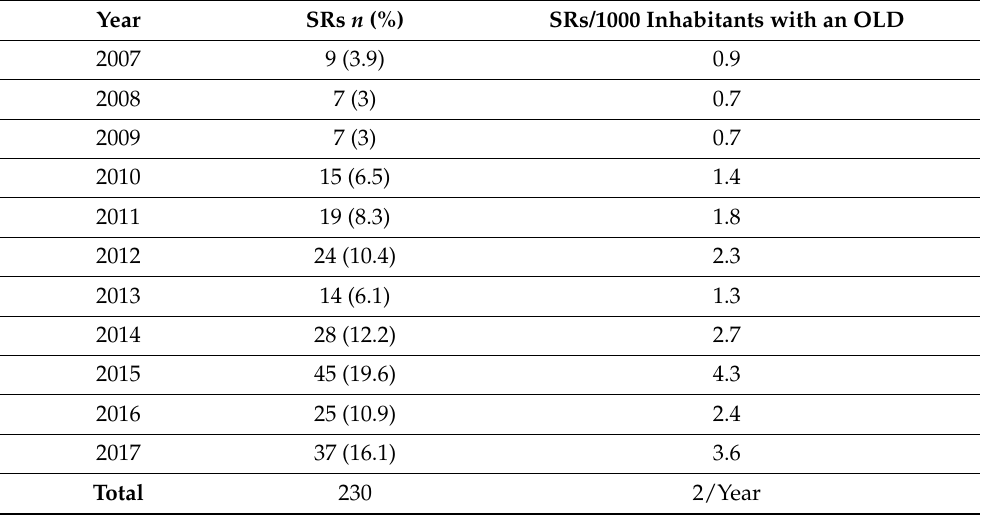
Table 2. Spontaneous Reports (SRs) frequency distribution of SRs over the years, adjusted to the estimated Portuguese population with asthma and asthma, chronic obstructive pulmonary disease. Year SRs n (%) SRs/1000 Inhabitants with an OLD 2007 9 (3.9) 0.9 0.7